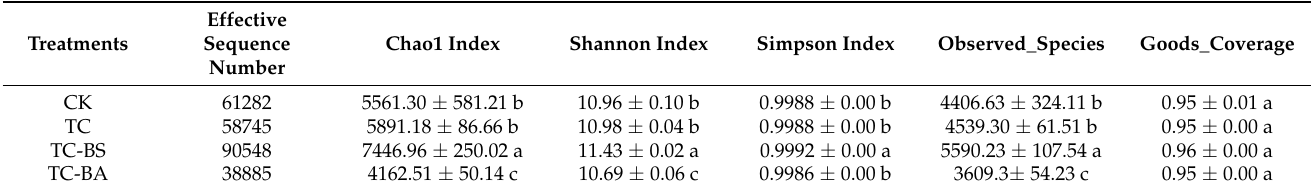
Table 2. Effect of applying tomato plant residue compost and PGPR on the alpha diversity of ginger field soil bacteria.